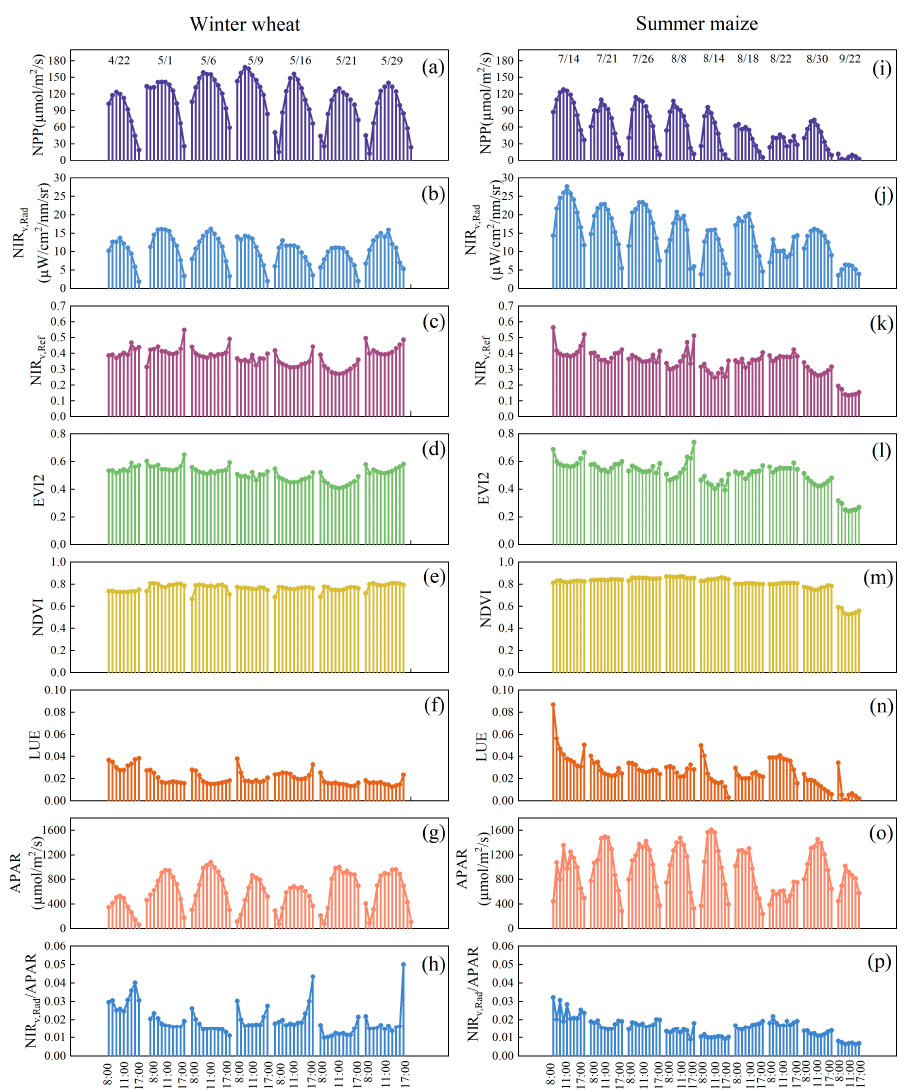
Figure 2. The NPP (µmol/m 2 /s) and NIR v,Rad (µW/cm 2 /nm/sr), NIR v,Ref , enhanced vegetation index-2 (EVI2), NDVI, LUE (ratio of organic matter produced to solar energy received by plants), APAR (µmol/m 2 /s) and the changes in NIR v,Rad /APAR(mWsnm/sr/µmol) of winter wheat and summer maize throughout the growth period. All data are hourly from 8:00 to 17:00 on a day. The data of winter wheat with adequate moisture are analyzed. Where Figures 2a–2h represent changes in winter wheat and Figures 2i–2p represent changes in summer maize.